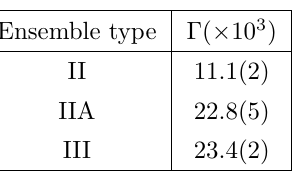
Best fit values for the kinetic constant Γ for the three ensemble types used in our simulations.